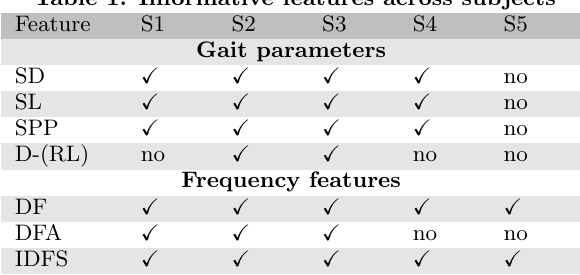
Table 1: Informative features across subjects Feature S1 Gait parameters